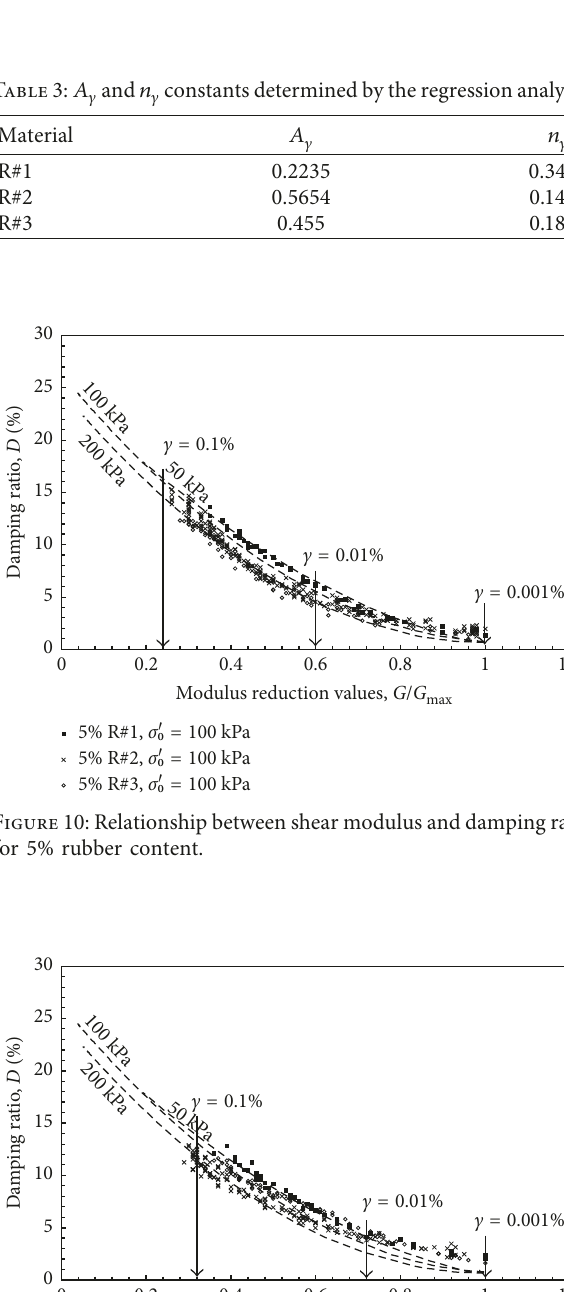
3 constants determined by the regression